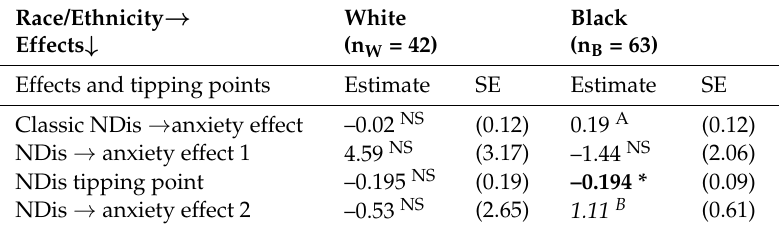
Table 2. Estimates of classic linear slopes and segmented effect estimates and tipping points, by race/ethnic (R/E)